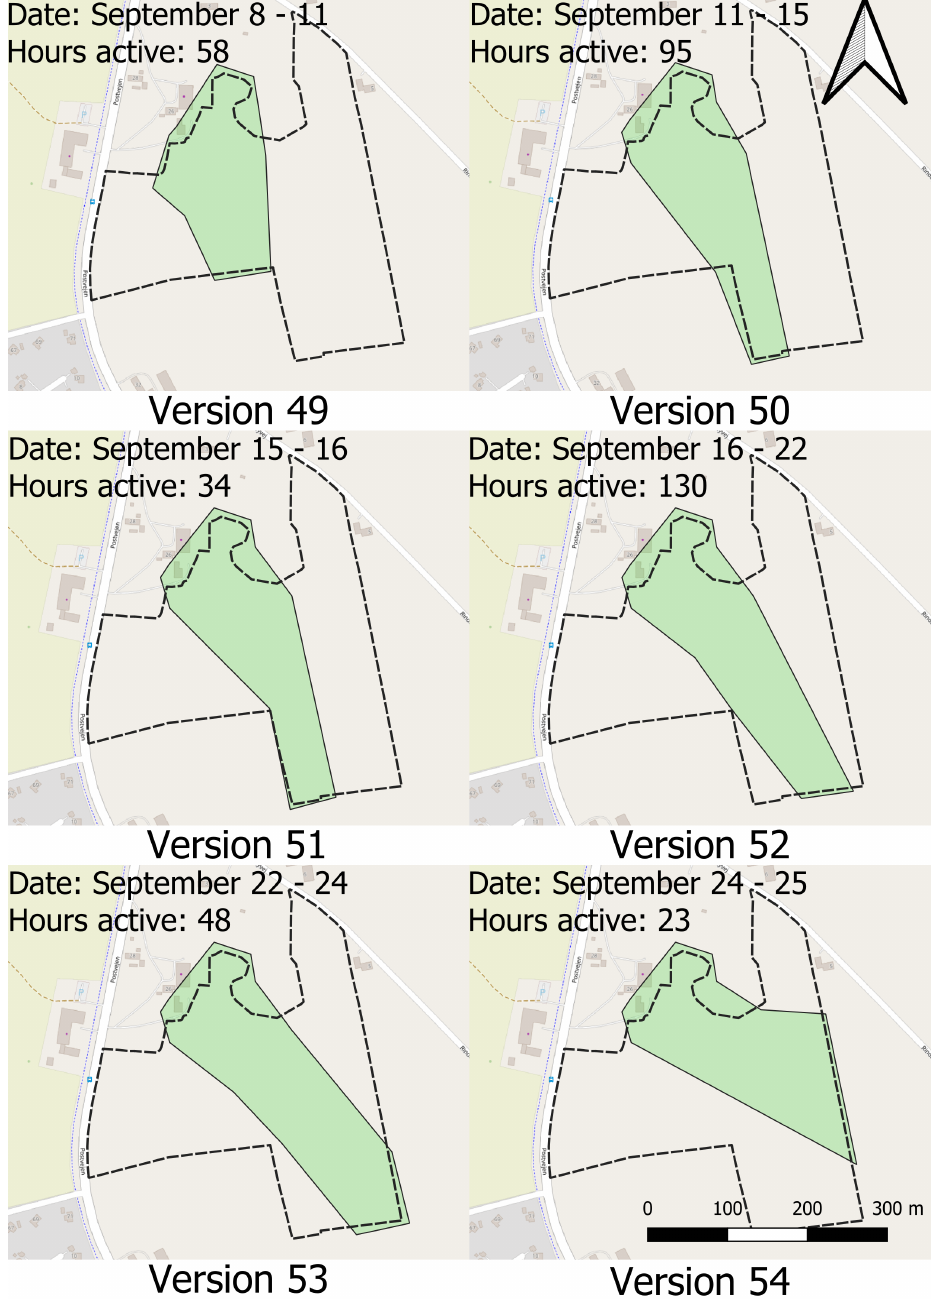
Figure A9. Virtual enclosure version 9 dating from 8 September to 25 September. The dashed black line represents the physical fence surrounding the 8.2 ha grazing area. The marked green area represents the virtual enclosure. Only virtual enclosures active for more than 12 h were included. The coordinates of the upper left corner of the map frame are 55°25 (cid:48) 23.131 (cid:48)(cid:48) E 8°23 (cid:48) 53.531 (cid:48)(cid:48) N. Map data from OpenStreetMaps